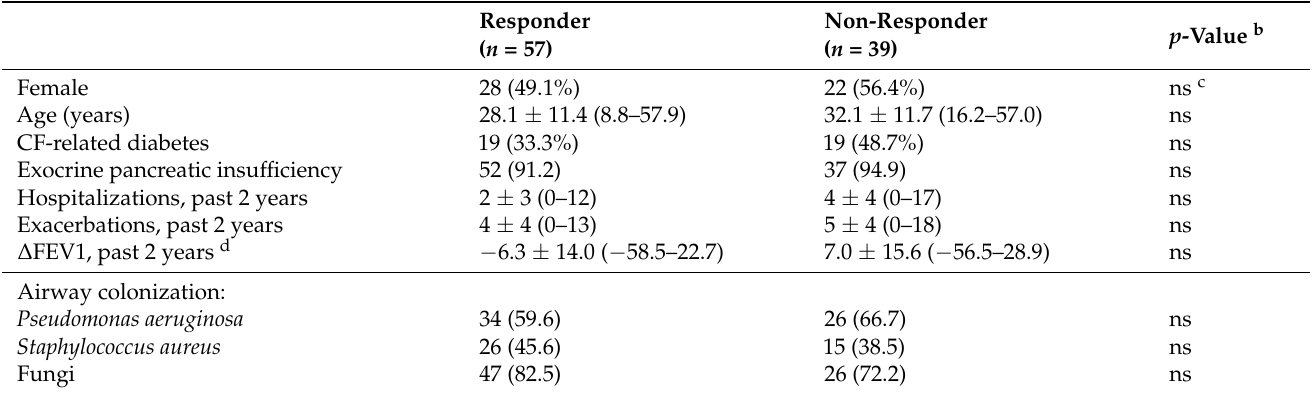
Table 5. Response to antibiotic therapy. Analysis shown for patients with complete data on days 0 and 28 a